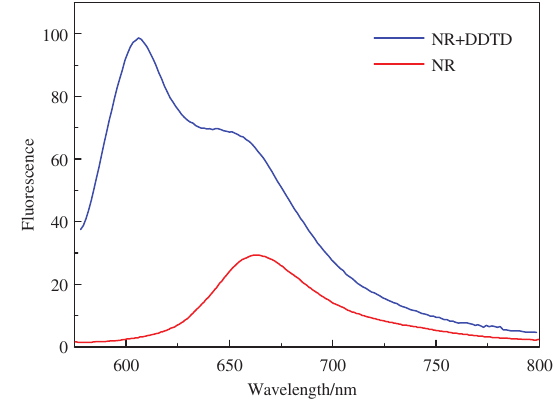
Fluorescence spectra of aqueous solutions of 0.5 µ M pure NR and in the presence of 10 µ M DDTD ( Hassoon and Schechter 1998